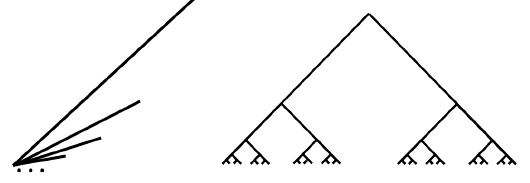
Figure 3. The F ω and Gehmann dendrites.